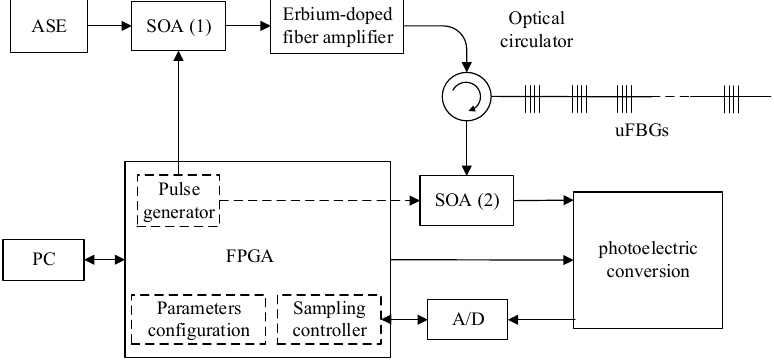
Figure 2. Schematic of the interrogation system.